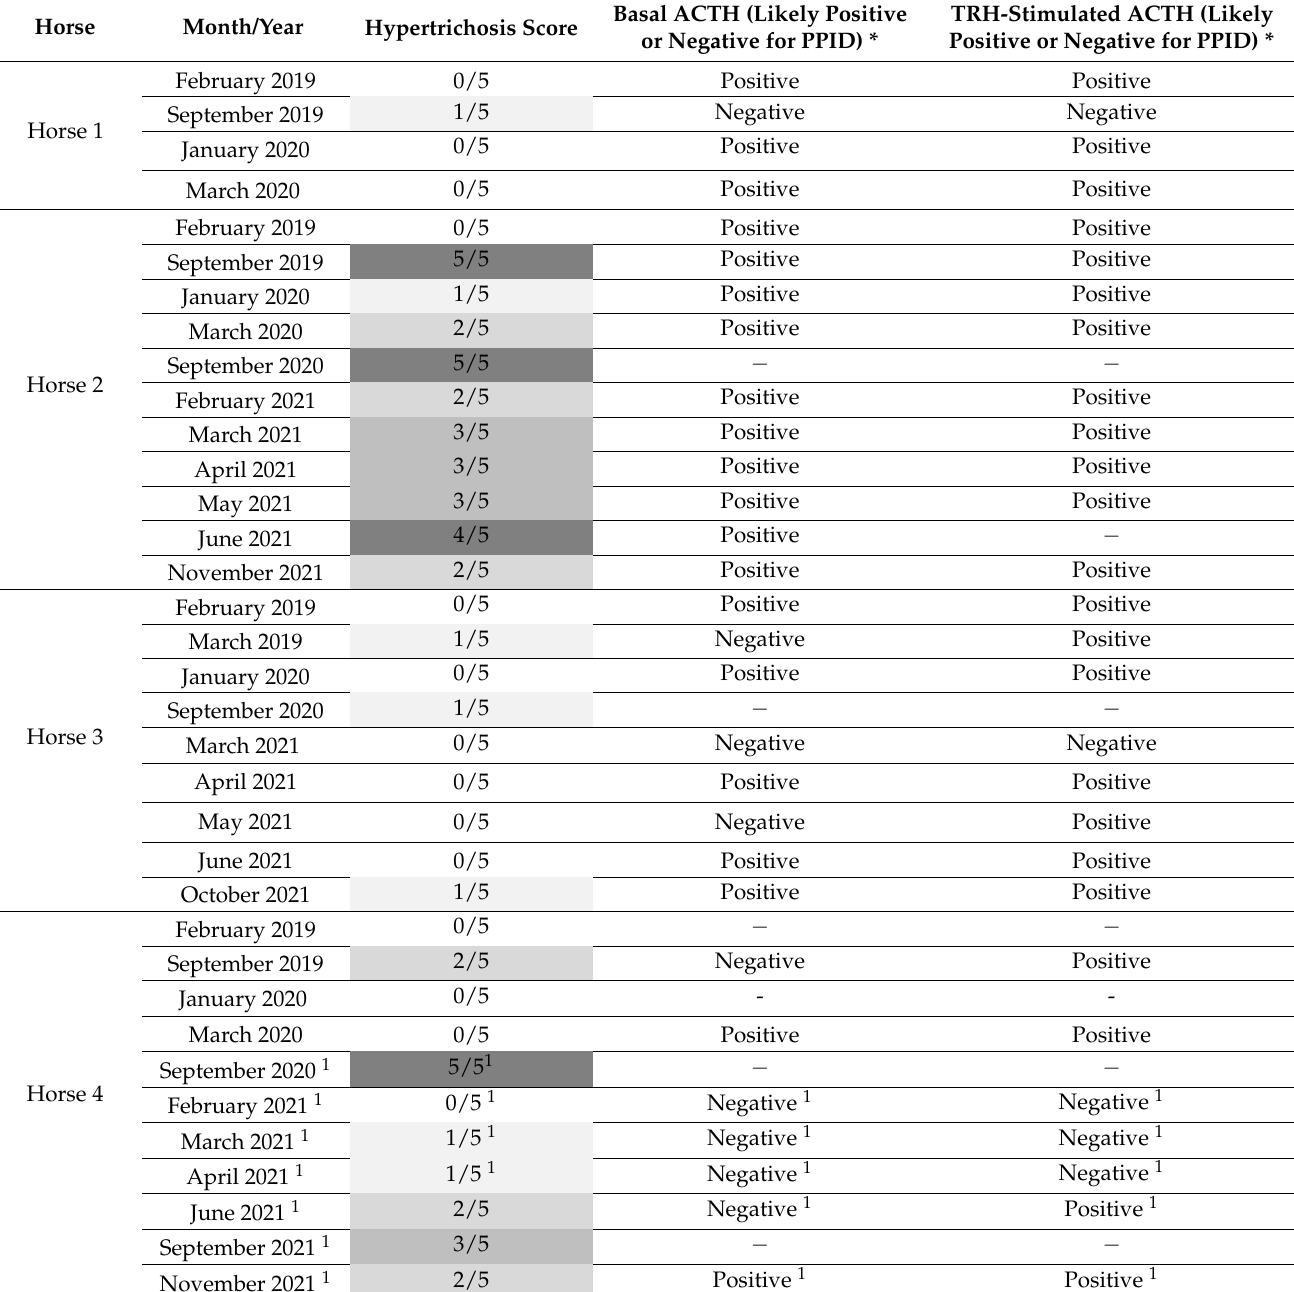
Table 2. Hypertrichosis score and interpretation of basal and TRH-stimulated ACTH concentrations based on